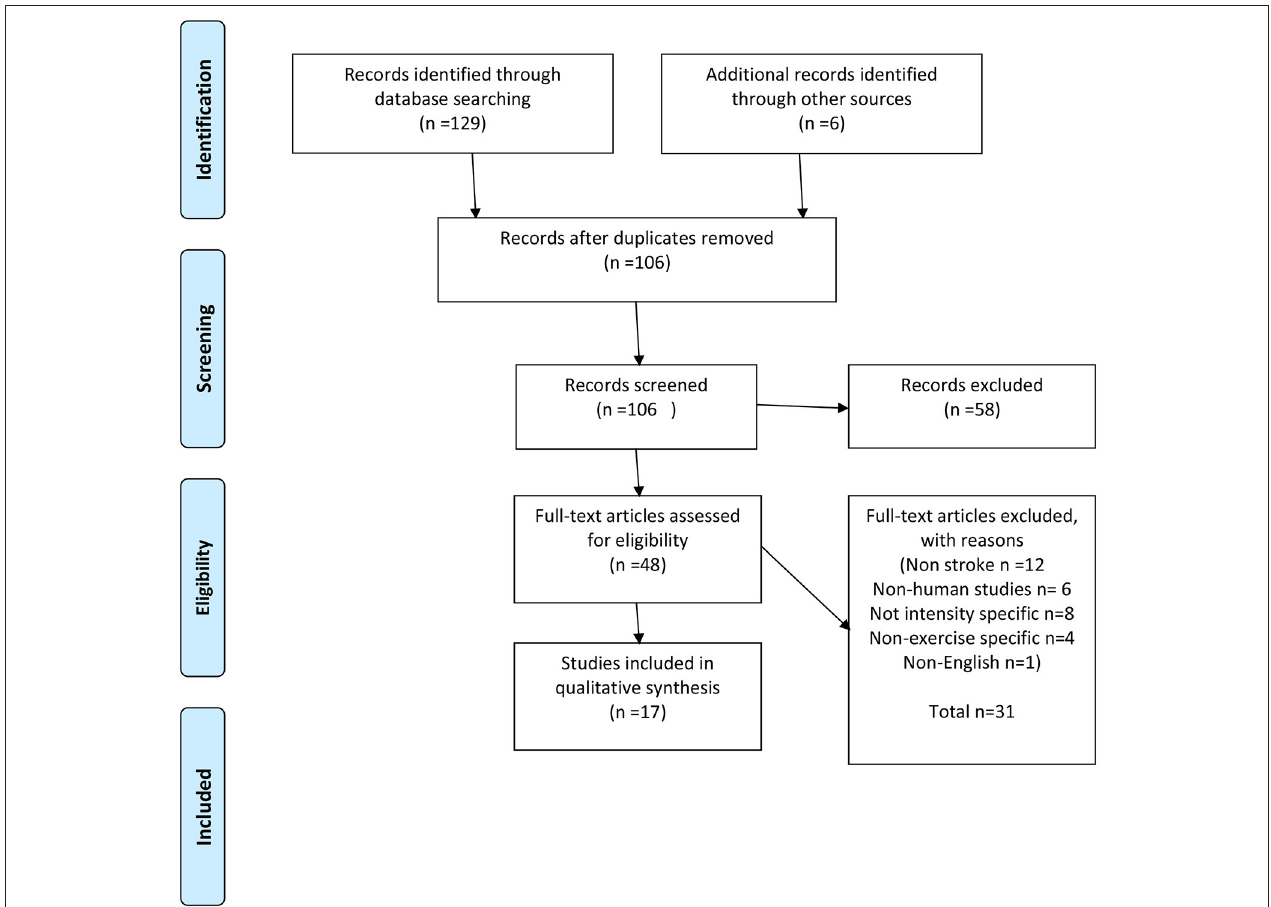
FIGURE 1 | Prisma flow